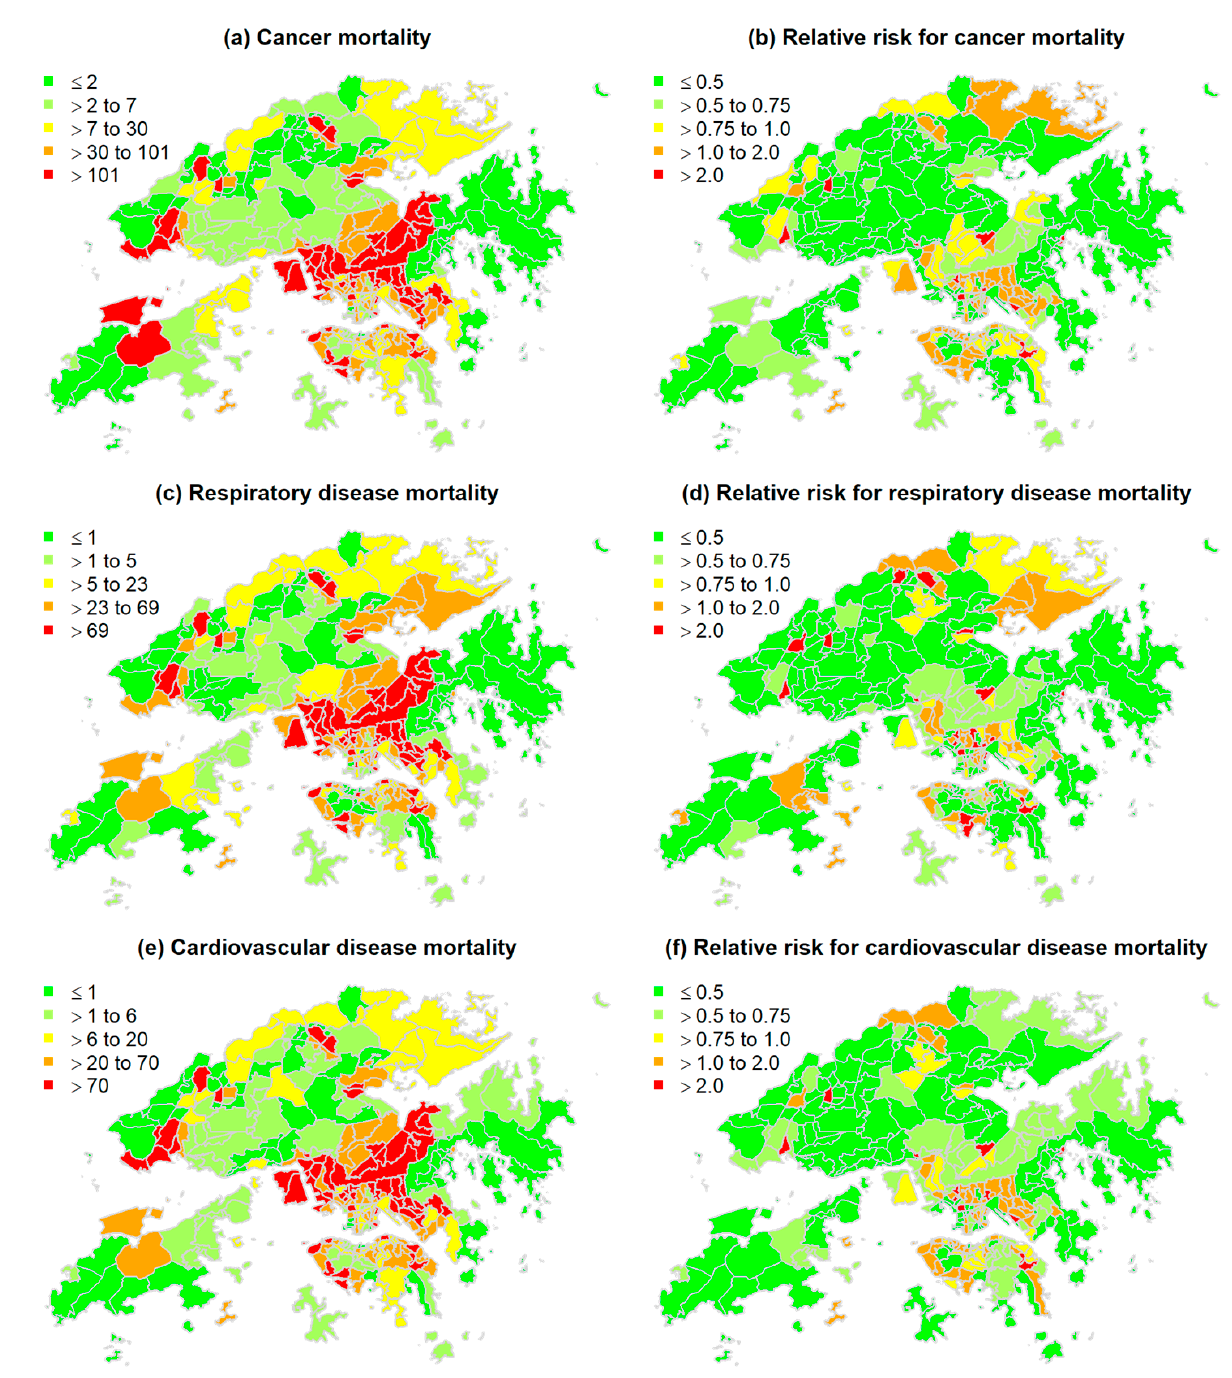
Figure 5. Cancer, respiratory disease, and cardiovascular disease mortalities and crude relative risk of mortality in Hong Kong in 2016.